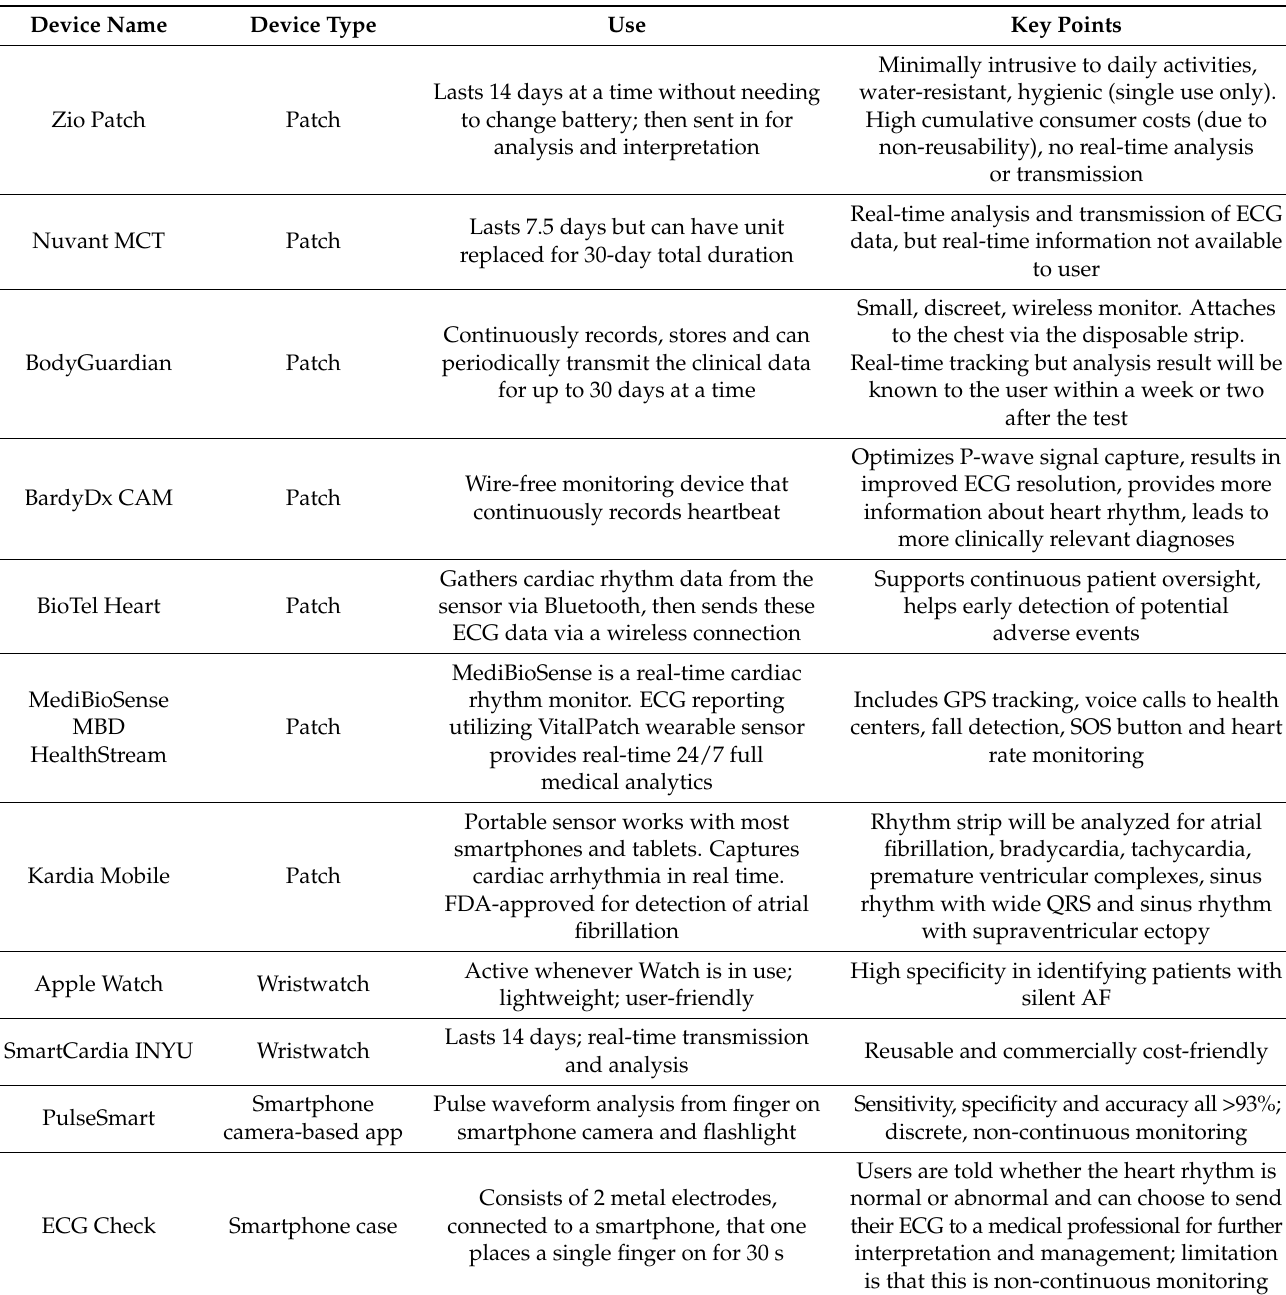
Table 1. Examples of wearable devices for the detection of arrhythmias available on the